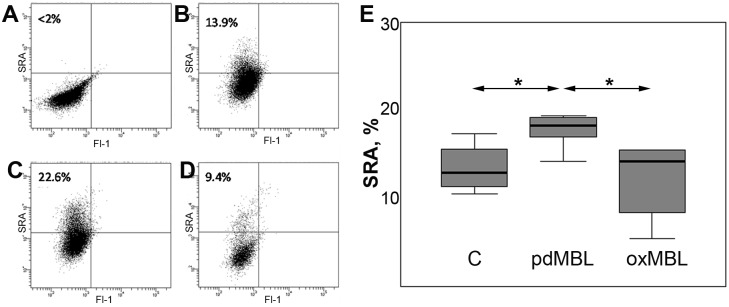
Oxidation negated the stimulatory effects of pdMBL on BAL-derived alveolar macrophage surface expression of SRA detected by flow cytometry.
A–D. Representative flow cytometry plots showing SRA expression following treatment with pdMBL or oxMBL. Debris, lymphocytes and cell fragments were firstly excluded based on forward- and side-scatter characteristics then macrophages identified by positive staining for CD13 and high autofluorescence (not shown). A. Control tube of alveolar macrophages stained with IgG control was included and the staining patterns used to set quadrant markers for flow cytometric analysis of B. SRA expression in untreated macrophages (13.9%), C. SRA expression in macrophages treated with plasma-derived MBL (22.6%), D. SRA expression in macrophages treated with oxidized MBL (9.4%). E. There was a significant increase (*, p<0.05; Wilcoxon; data pooled from 7 experiments using BAL-derived alveolar macrophages) in % expression of SRA in the presence of pdMBL. Oxidation of MBL abrogated this stimulation effect.